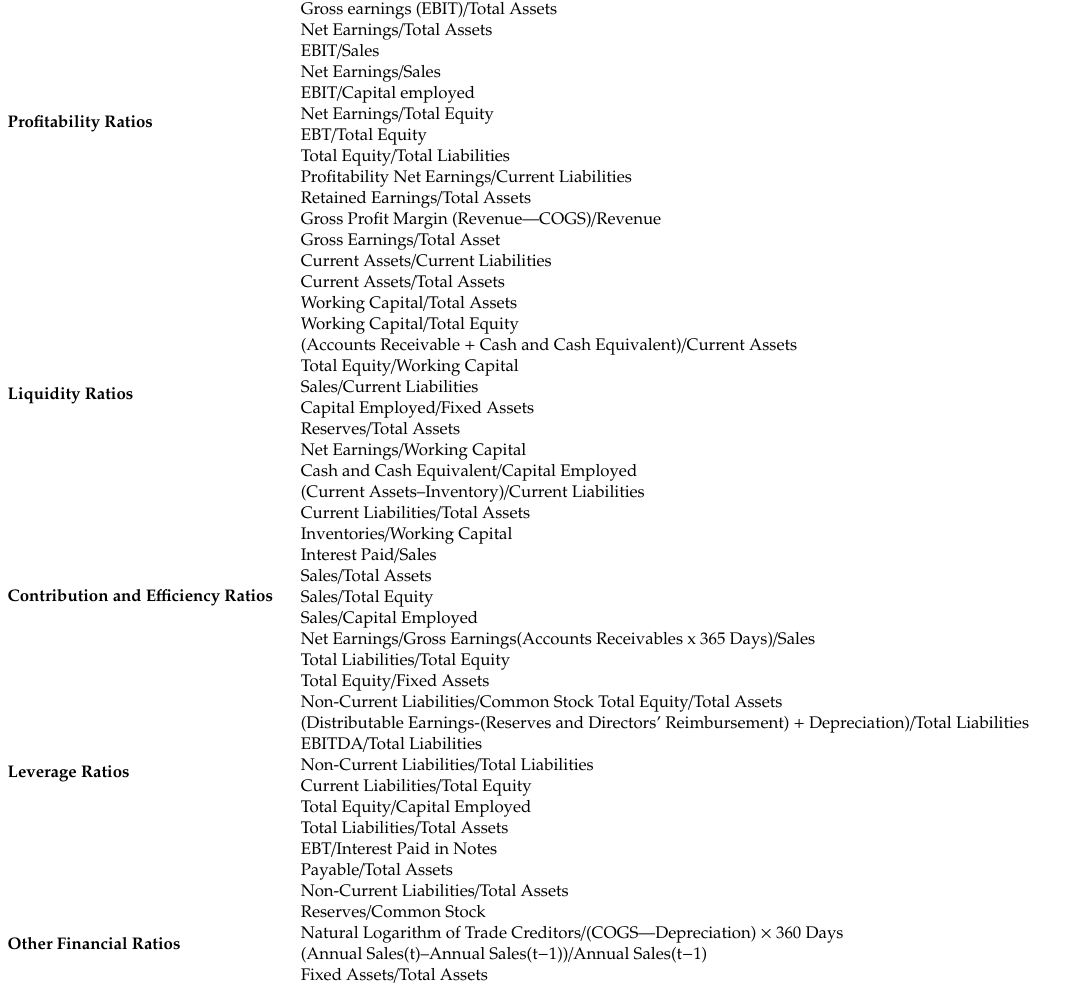
Table 1. The ensemble of ratios used in the